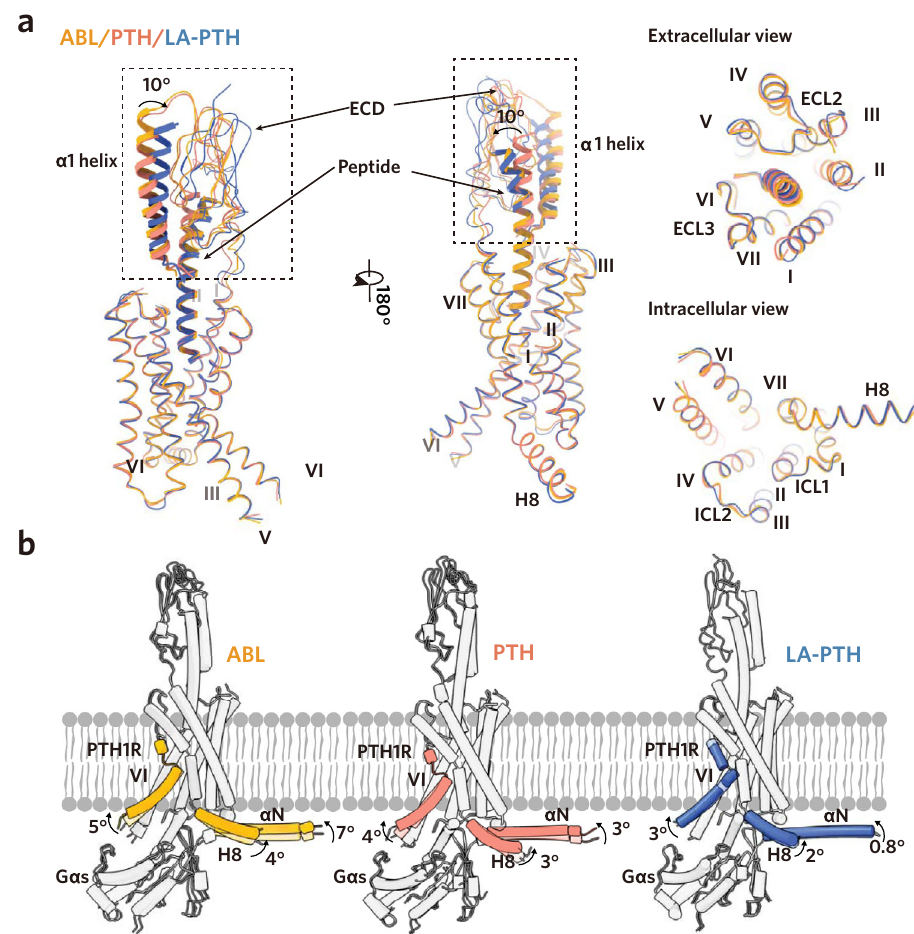
Fig. 2 | Structural comparisons and dynamics of the peptide-bound PTH1R-Gs complexes. a Structural comparisons ofthe ABL – , PTH – and LA-PTH – bound (PDB 6NBF) PTH1R complexes. Structures were aligned by the TMD of PTH1R. b